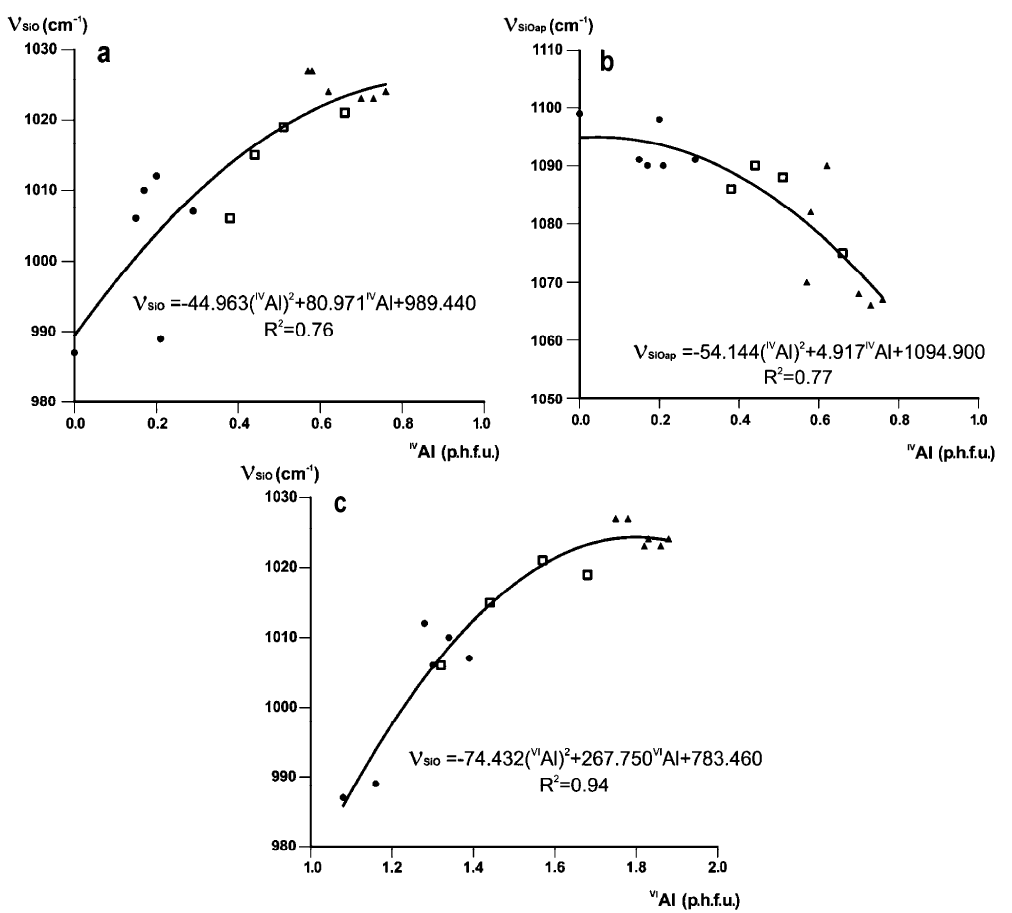
Figure 6. Band positions (cm − 1 ) of ( a ) ν (SiO) and ( b ) ν (SiO apical ) plotted against IV Al contents (cations p.h.f.u. ), and ( c ) ν (SiO) plotted vs. IV Al contents for Fe-poor K-dioctahedral 1 M micas (cations p.h.f.u. ). Symbols as in Figure 2.